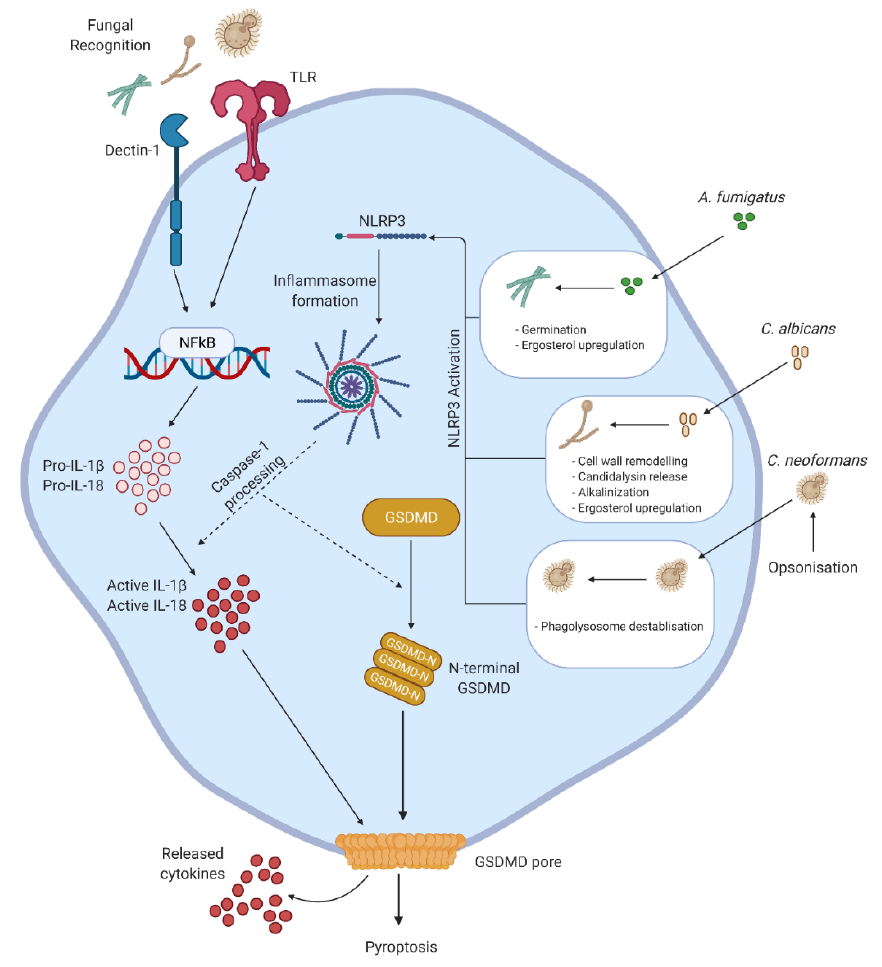
Figure 2. Fungal induction of pyroptosis. Recognition of fungi by patten recognition receptors such as dectin-1 and toll-like receptors (TLR) primes cells by upregulating the expression and synthesis of pro-interleukin (IL)-1 β and pro-IL-18. Once the fungi are inside the phagolysosome, a number of fungal-dependent mechanisms lead to the activation of the nod-like receptor (NLR) family pyrin domain containing 3 (NLRP3), including morphological changes, ergosterol upregulation, phagolysosome alkalinization, or destabilization through the release of virulence factors. Formation of the NLRP3 inflammasome leads to the processing of caspase-1 to its active form. Active caspase-1 processes pro-IL-1 β and pro-IL18 to their biologically active forms as well as cleaving gasdermin- D (GSDMD) to its N-terminal form. N-terminal GSDMD oligomerizes and translocates to the cell membrane forming pores which result in lytic cell death and the release of pro-inflammatory cytokines and damage-associated molecular patterns